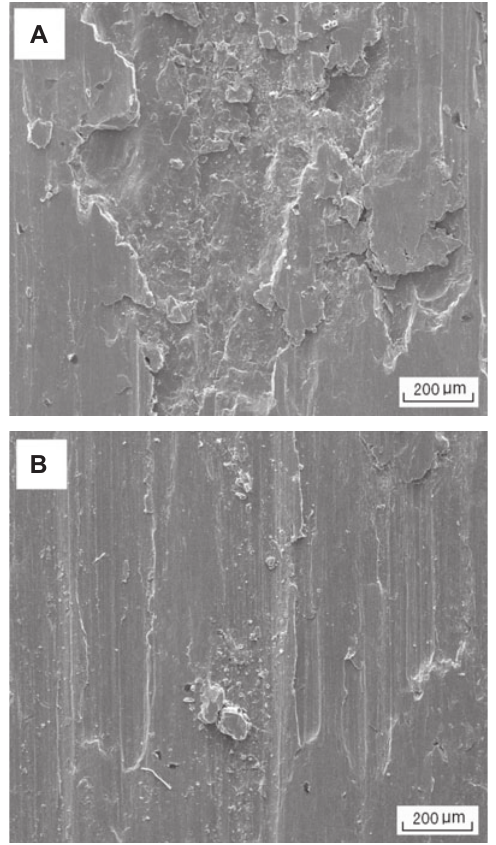
Figure 4 SEM micrographs of the worn surfaces of the TiC/316L composites at 100 N (sliding distance 1000 m): (A) prepared by conventional PM technique; (B) prepared by